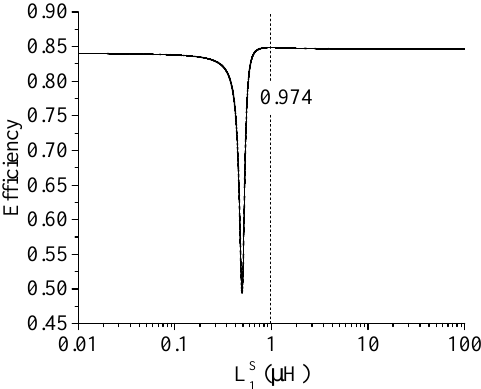
Figure 6. The simulated efficiency η as a function of the compensating susceptance L S while keeping the other system parameters at their optimal value.